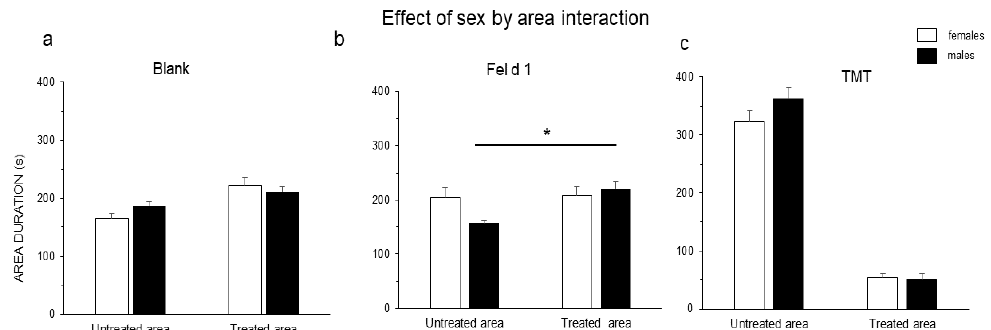
Figure 2. Durations in the treated vs. untreated areas for each treatment showing sex-by-area interactions ( a – c ). GLM procedure was used to evaluate the effects of the sex-area interactions, followed by a Tukey test and LSmeans comparisons. The results are shown as the mean ± SE. The significance threshold is fixed at 5%. n.s, non-significant. p < 0.05